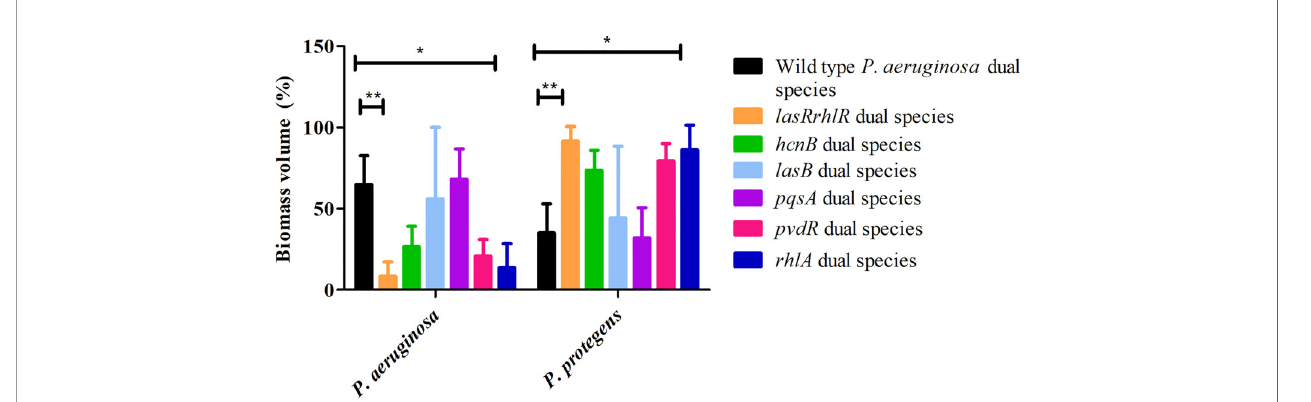
FIGURE 5 | Proportions of P. protegens - P. aeruginosa dual species bio fi lm containing mutants of QS regulated effectors. The proportions of the two species in the mixed species bio fi lm containing either the P. aeruginosa wild type, the QS mutant lasRrhlR or the QS target mutants hcnB , lasB , pvdR , rhlA , or pqsA after 3 days of cultivation. Bar charts depict the percentages of P. aeruginosa and P. protegens in the wild type or the mutant dual species bio fi lms. The proportions were derived by cultivating bio fi lms under fl ow cell conditions followed by quantitative image analysis of two independent biological replicates. Error bars represent standard deviations (n = 2). * and ** denote signi fi cant difference by two-way ANOVA followed by Tukey ’ s post-test ( P < 0.05; P <